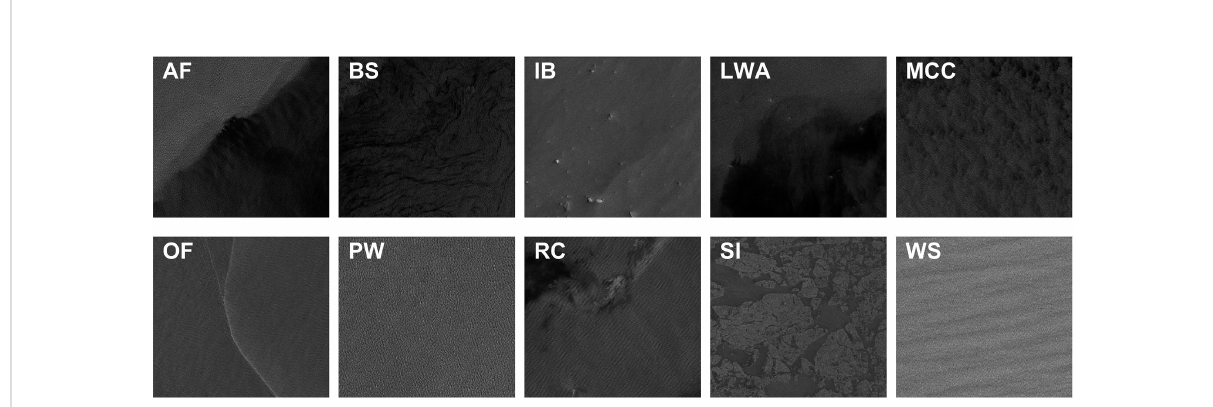
FIGURE 1 Description of the TenGeoP-SARwv dataset. Ten examples of de fi ned geophysical phenomena: atmospheric fronts (AF); biological slicks (BS); icebergs (IB); low-wind areas (LWA); microconvective cells (MCC); oceanic fronts (OF); pure ocean waves (PW); rain cells (RC); sea ice (SI); and windstreaks